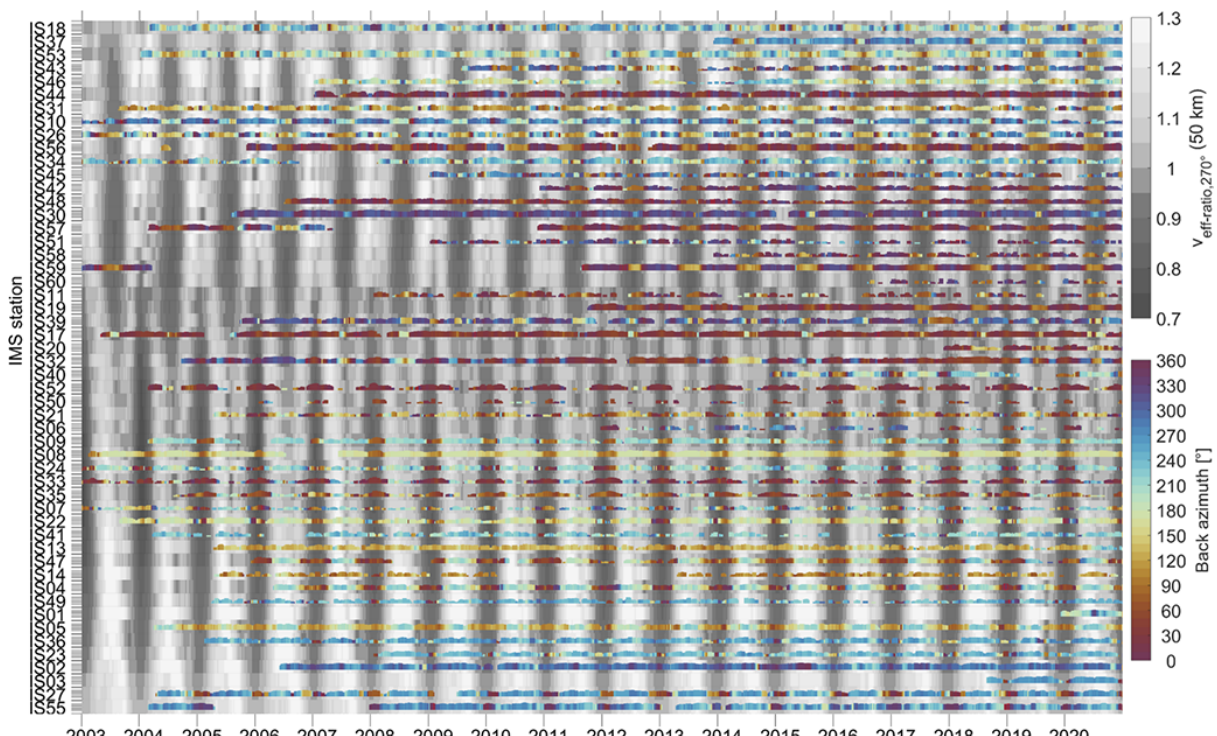
Figure 13. Global picture of the back azimuth variation in the maw product (0.02–0.07Hz), averaged in time windows of 30d. For each time step (7d), the mean back azimuth is color-coded. Grayscale depicts the v eff-ratio calculated from the temperature and wind profiles (ECMWF) at each station for arrivals from westerly directions (270 ◦ ). IS20 marks the transition from the Northern to the Southern hemispheres. Note that the vertical extent of each colored line, which denotes the number of detections at a logarithmic scale, is not directly comparable to that of Fig. 11 (different